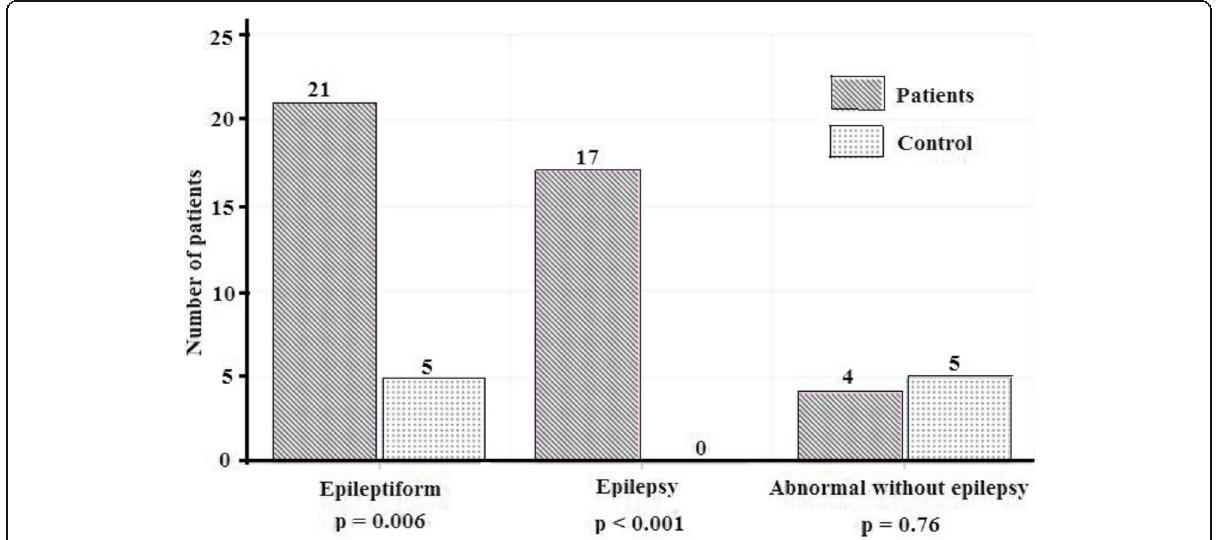
Fig. 1 Abnormal epileptogenic EEG activity in patients with SLI